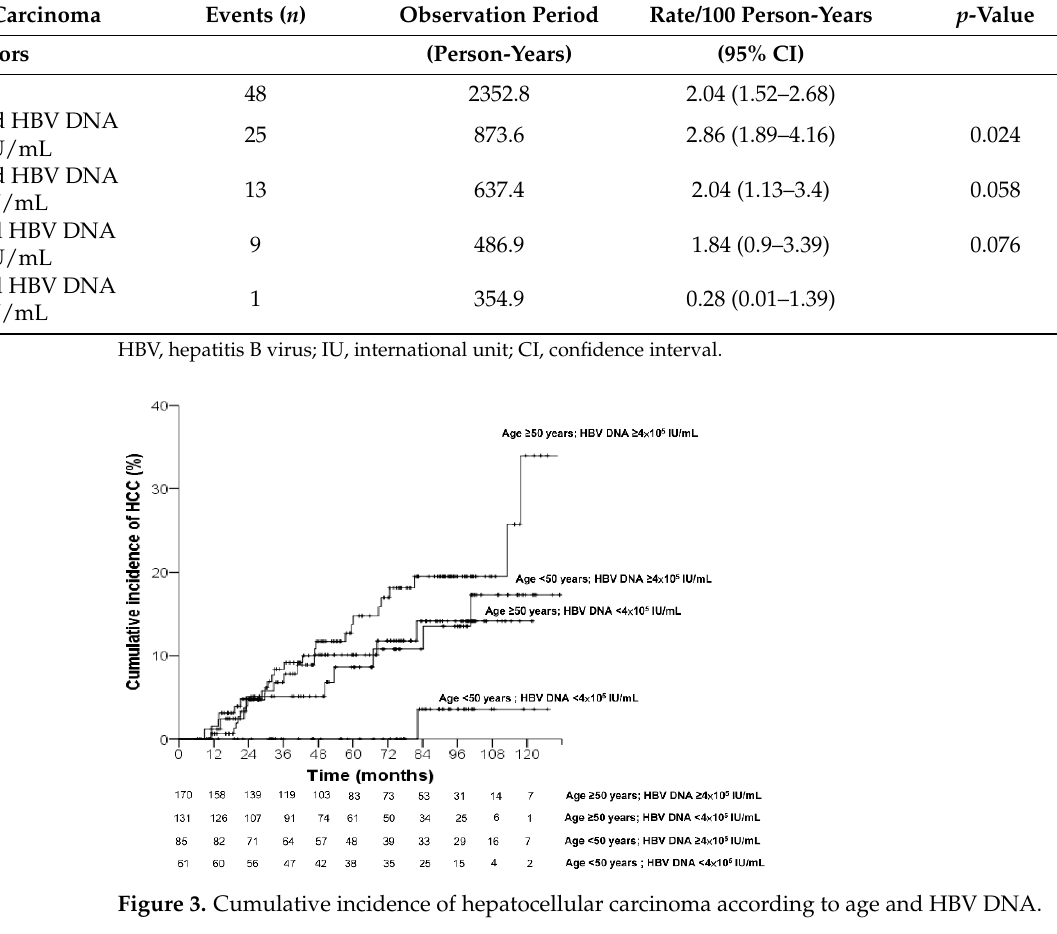
Table 4. Incidence rates of hepatocellular carcinoma stratified according age and HBV DNA.